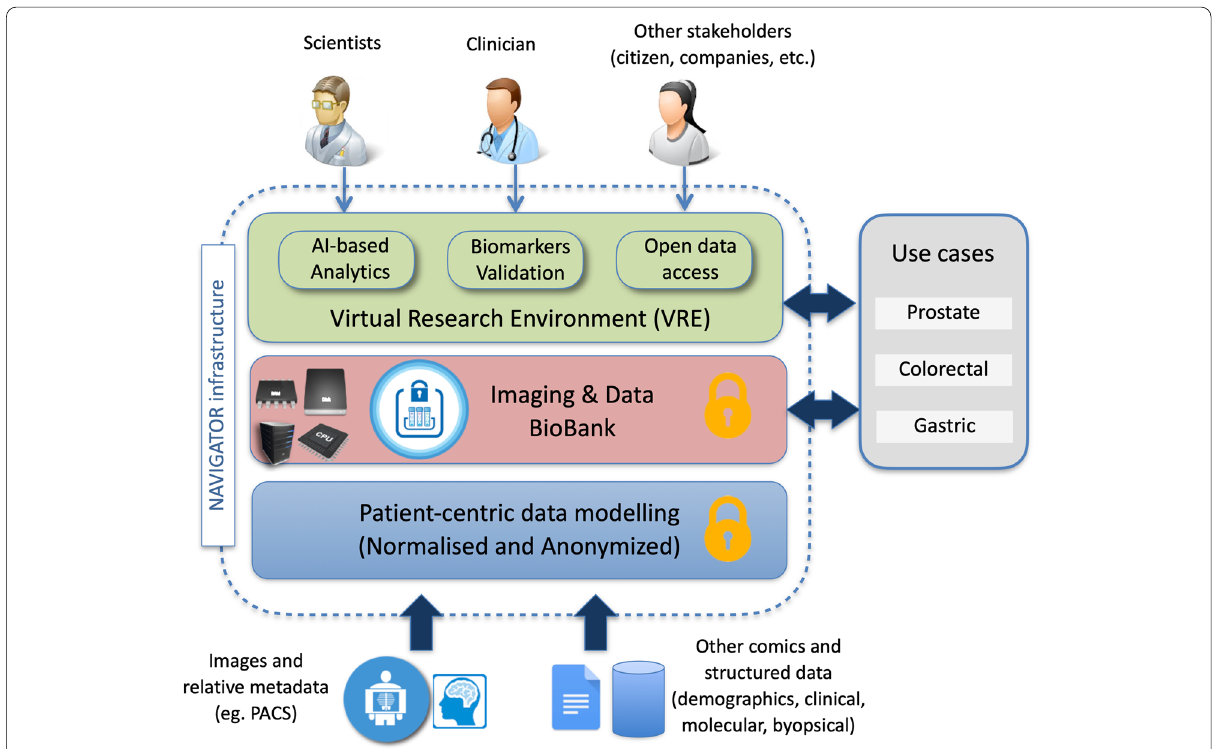
Fig. 1 The envisioned architecture of the NAVIGATOR